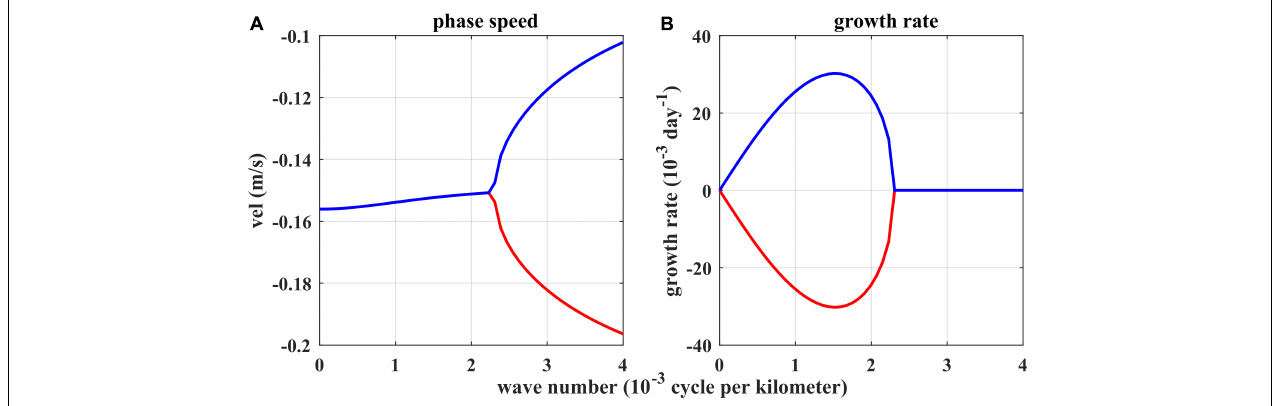
FIGURE 13 | Phase speed (A) and growth rate (B) as a function of zonal wavenumber k calculated from the 2.5-layer linearized reduced gravity